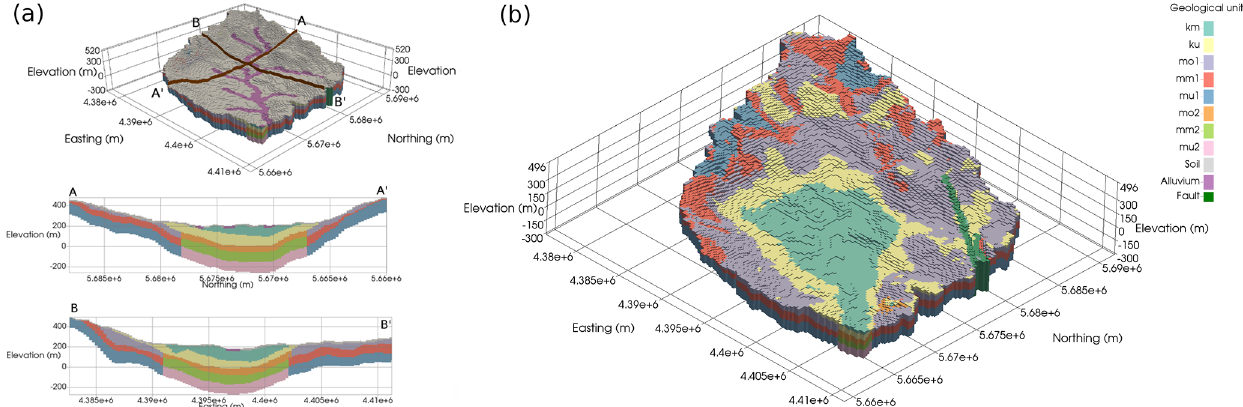
Figure 2. Geological zonation and three-dimensional mesh for the aquifer system in Nägelstedt subbasin (Jing et al., 2018a). Panel (a) underlines the the spatial pattern of alluvium and soil layers. Panel (b) further displays the zonation of deep geological units. Full names of the abbreviations used in the legend are listed as follows: km – Middle Keuper, ku – Lower Keuper, mo – Upper Muschelkalk, mm – Middle Muschelkalk, mu – Lower